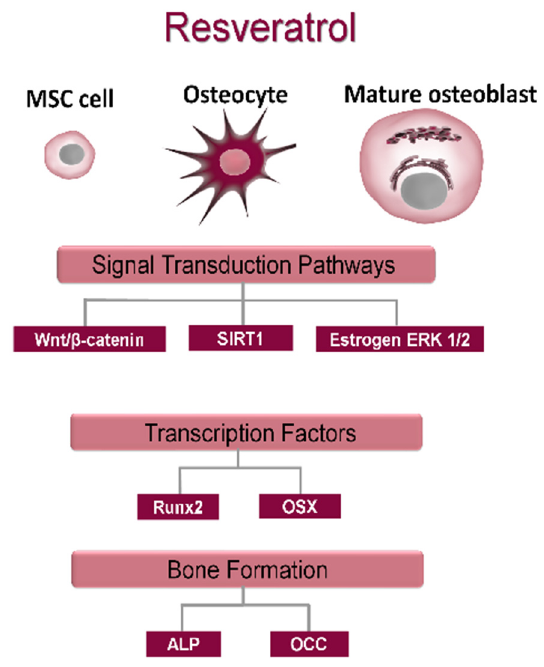
Figure 8. Osteogenic effects of resveratrol in vitro. RSV influences estrogen-dependent and independent signal transduction pathways which modulate the gene expression of transcription factors Runx2 and osterix (OSX), regulating osteoblast differentiation and mineralization.